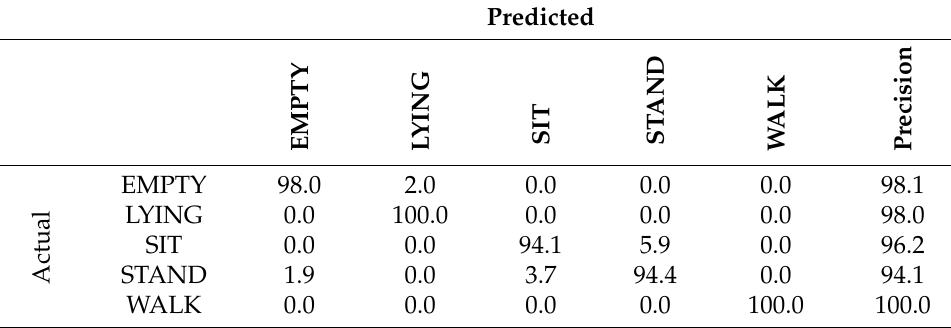
Table 7. Confusion matrix for LSTM HAR classification for Experiment